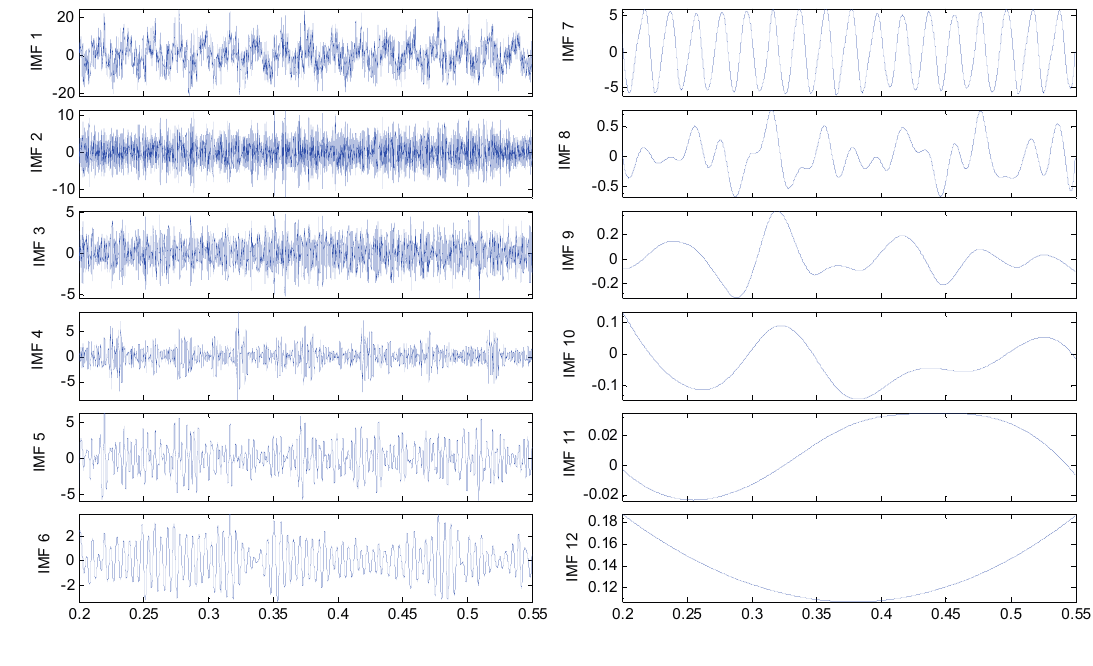
Figure 7. IMFs for the axle bearing vibration signal with cage fault.